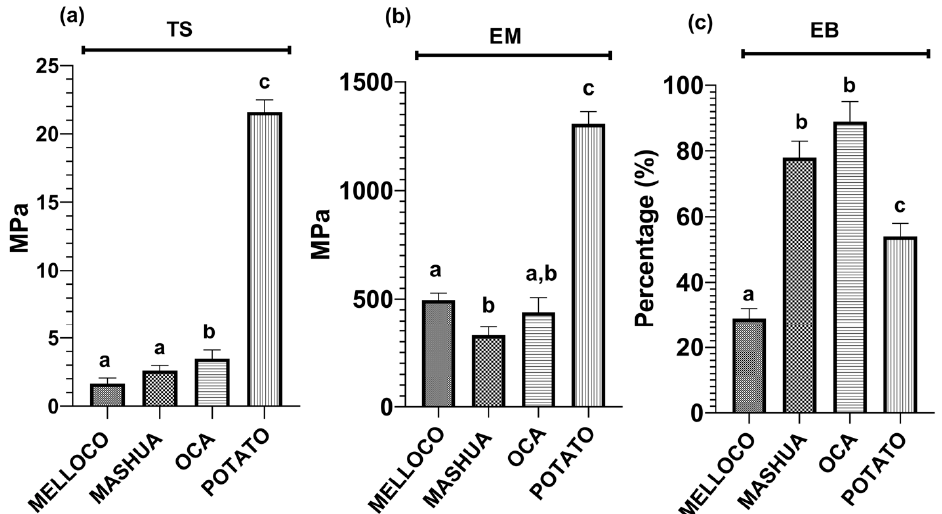
Figure 4. Mechanical properties obtained on the films extracted from each Andean tuber analyzed. Data shown are representative of five independent experiments and represent the mean ± SD. Different letters above the bars indicate significant differences ( p < 0.05 ANOVA post hoc Tukey’s test). ( a ) Tensile strength, ( b ) elastic modulus (Young’s modulus), and ( c ) elongation at